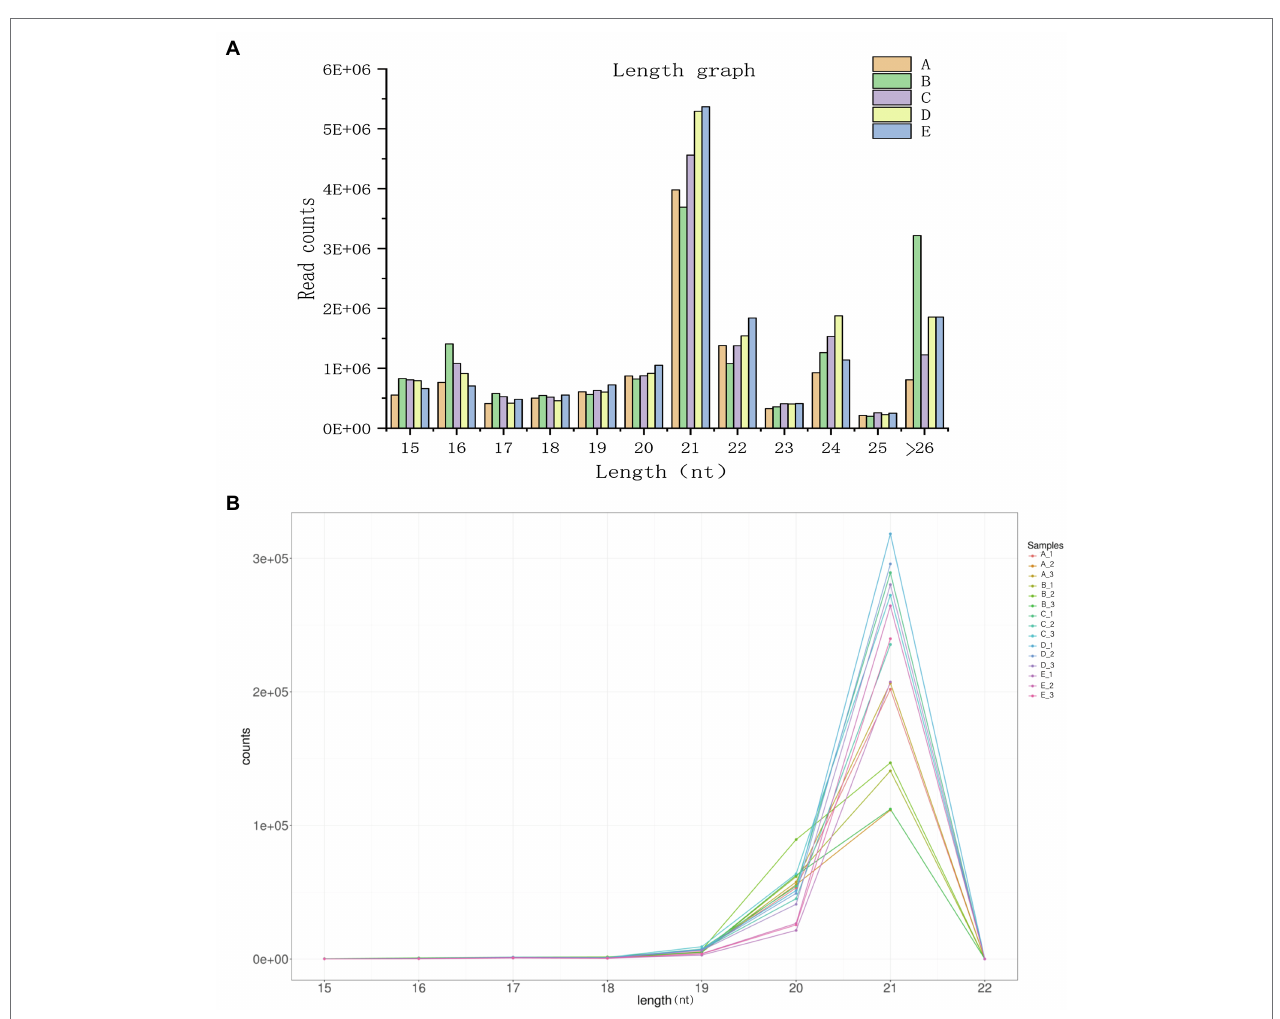
FIGURE 4 | (A) Length distribution statistics of clean reads. The x-axis represents the size of the small RNA, and the y-axis represents the number of read counts. (B) Known miRNA length distribution line graph. The x-axis presents the size of the miRNA, and the y-axis presents the number of read counts.